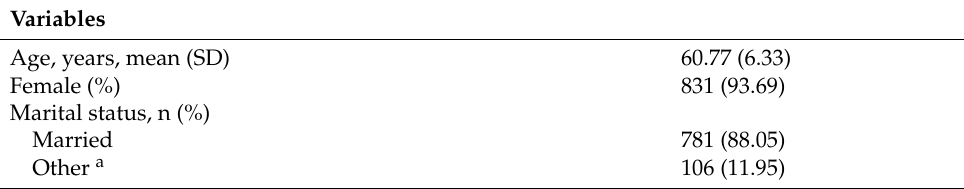
Table 2. Distribution of all participants according to general